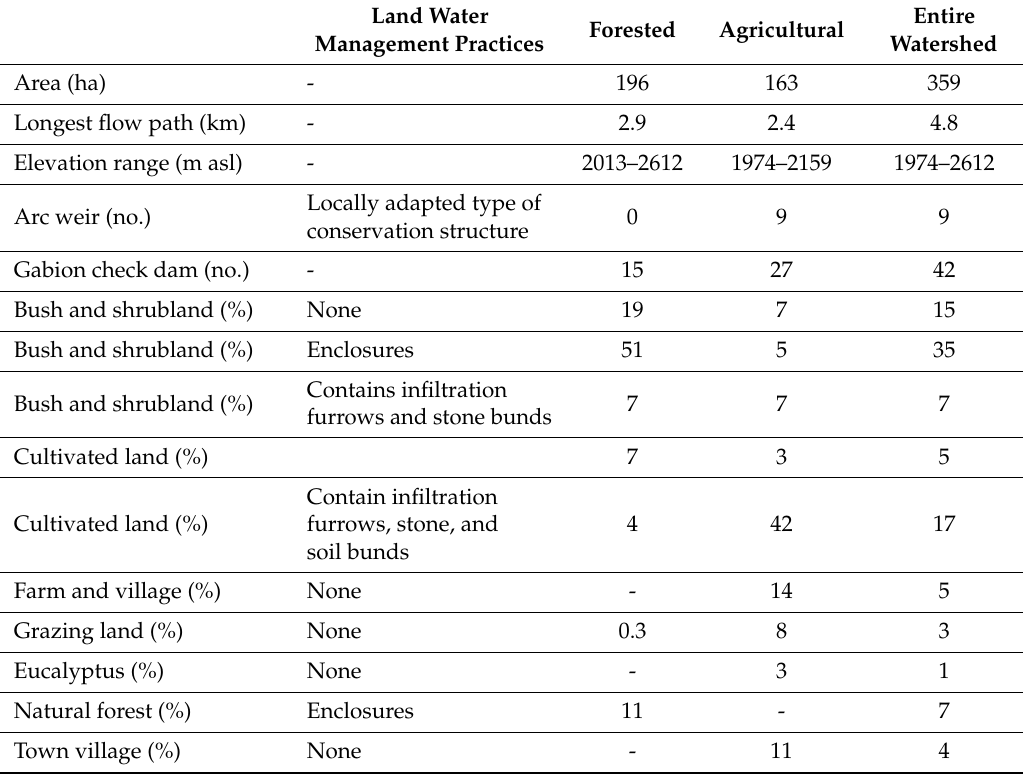
Table 1. Characteristics, land use, and land management practices of the upper forested and downslope agricultural and the entire Gomit watershed. LWM: land and water management